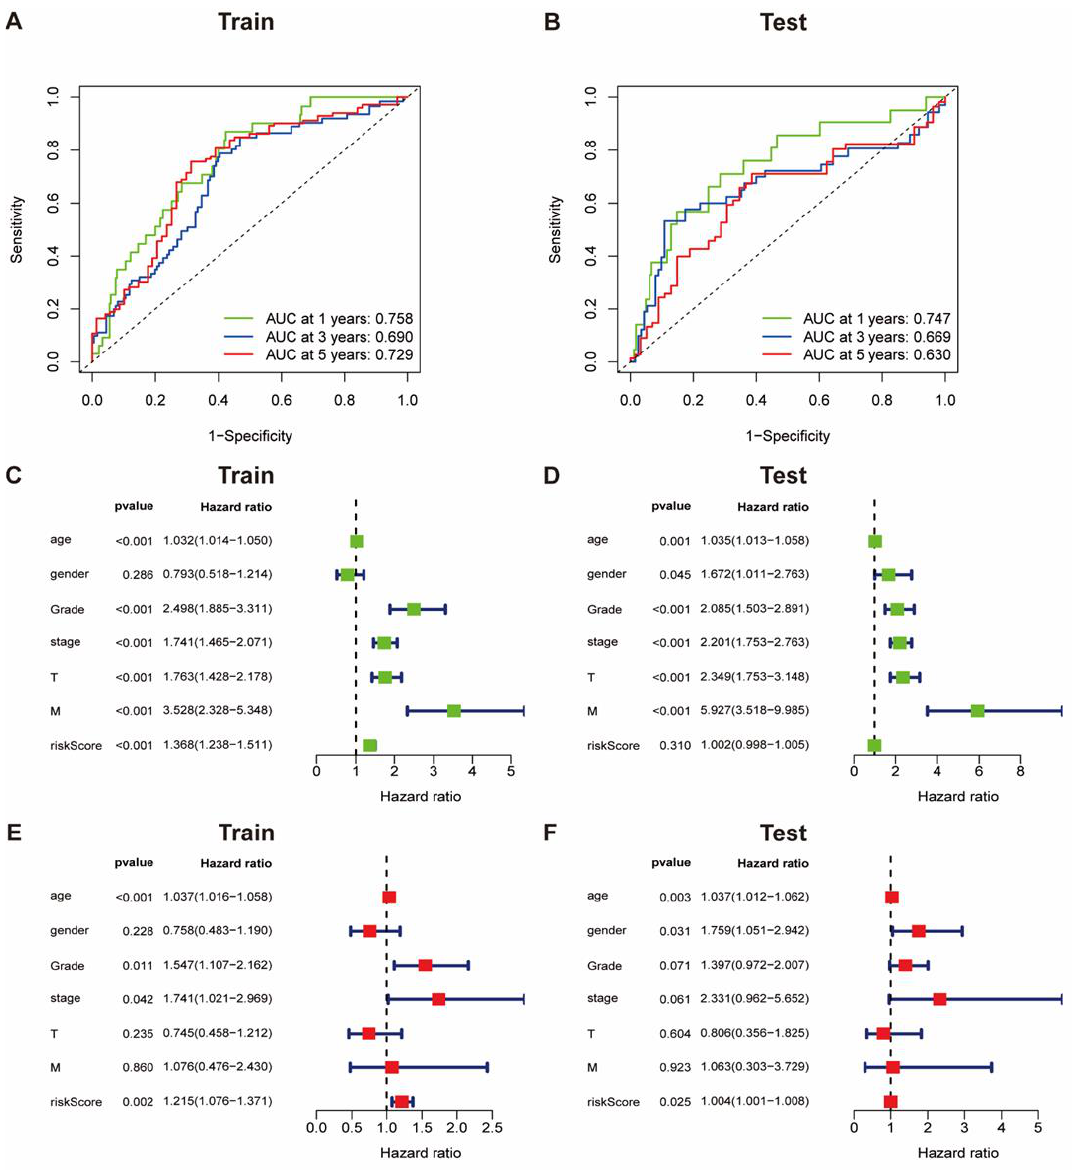
Figure 5. Prognostic value of the collagen-related signature in ccRCC. ( A , B ) ROC curves showing the predictive efficiency of the collagen-related signature on the 1-,3- and 5-years survival rate; ( C – F ) Univariate and multivariate cox regression analysis evaluating the independent prognostic value of collagen-related signature in terms of OS in ccRCC patients.